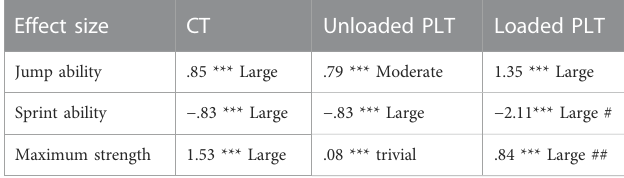
TABLE 4 Summary of meta-analysis results.